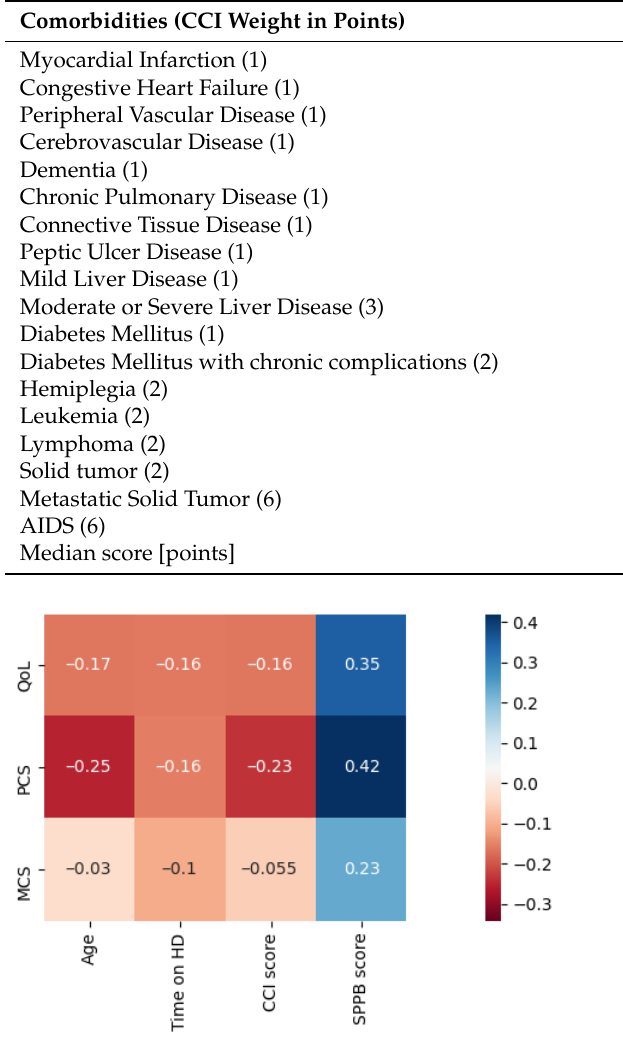
Figure 1. Correlation matrix visualizing correlations between SF-36 scores and age, HD vintage, CCI, and SPPB score. Positive correlations are visualized in shades of blue, and negative correlations are visualized in shades of red. Statistically significant correlations are marked with an asterisk. Table 3. Charlson Comorbidity Index scores.